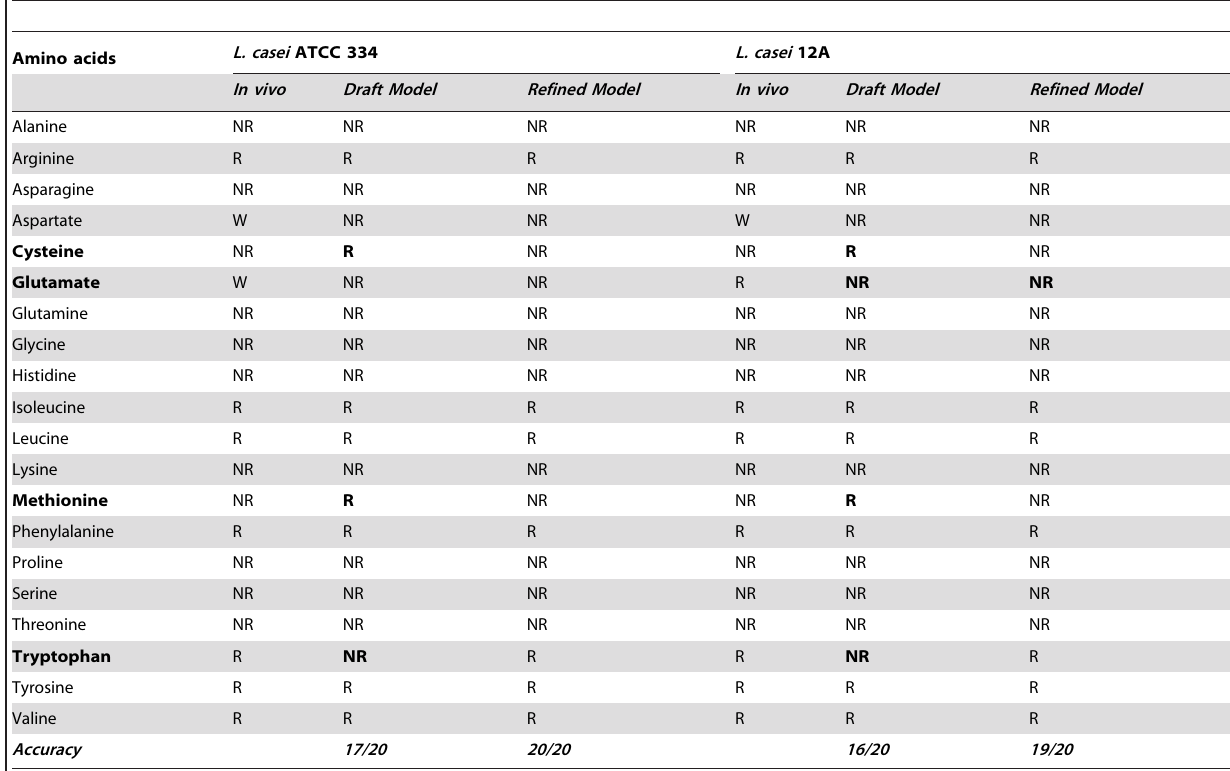
Table 3. The amino acid requirements of L. casei ATCC 334 and 12A as determined by in vivo experiments and flux balance analysis of the models prior to and after model refinement.